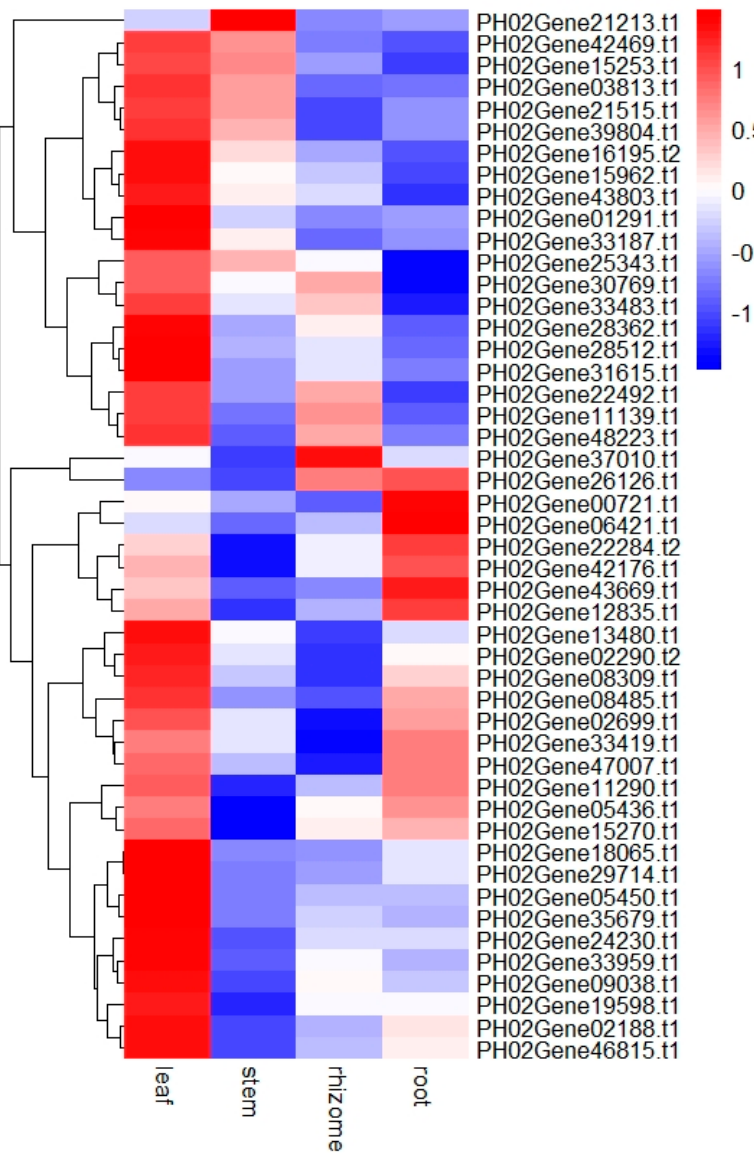
Figure 7. Expression profiles of PeUBP genes in different tissues of moso bamboo. Samples were from leaf, stem, rhizome, and root. The heatmap shows the hierarchical clustering of 48 PeUBP genes across the different tissues analyzed. The color scale presented vertically at the right side of the picture represents log10 expression values; blue and red represents low and high levels of transcript abundance. The mean values were obtained from three biological and three technical replicates.